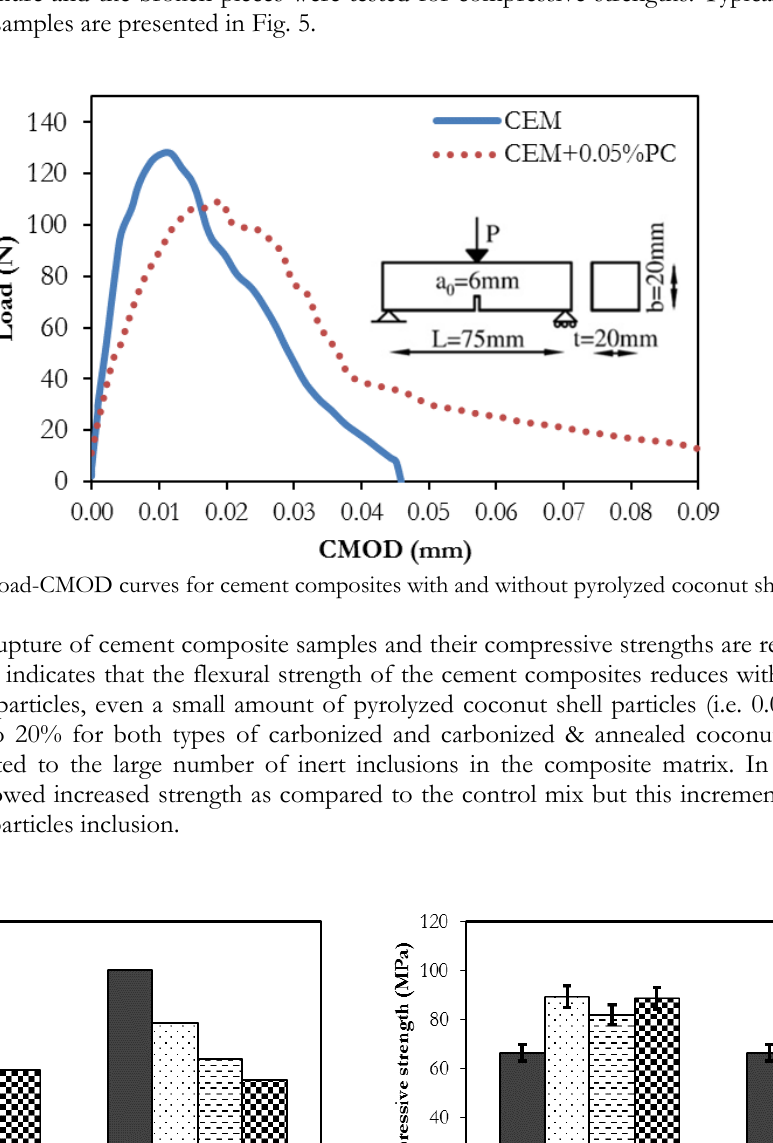
Figure 7: Compressive strength of the cement composites with PC & PCA particles